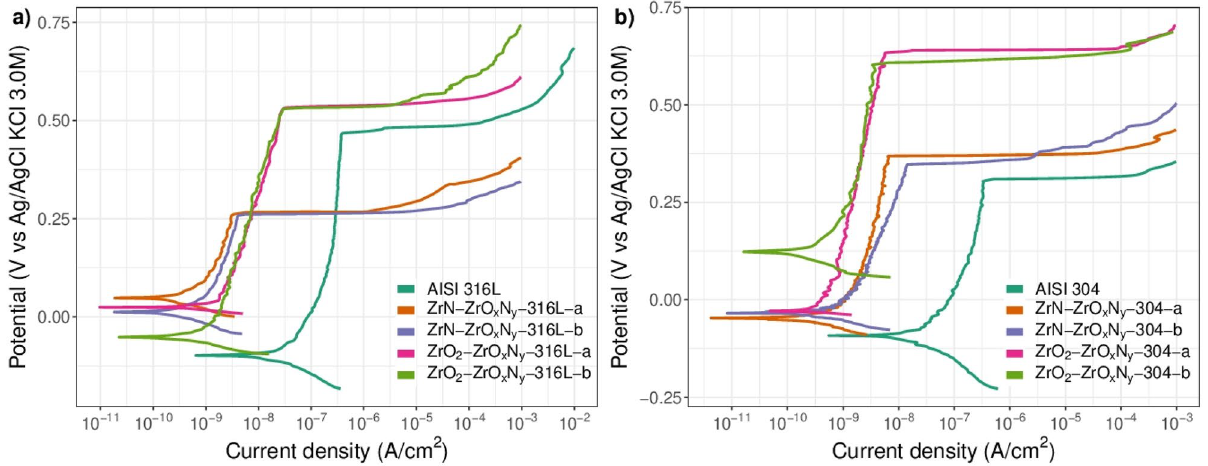
Figure 8. Linear polarization curves of the ZrO 2 -ZrO x N y , and ZrN-ZrO x N y deposited on ( a ) AISI 316 L and ( b ) AISI 304.